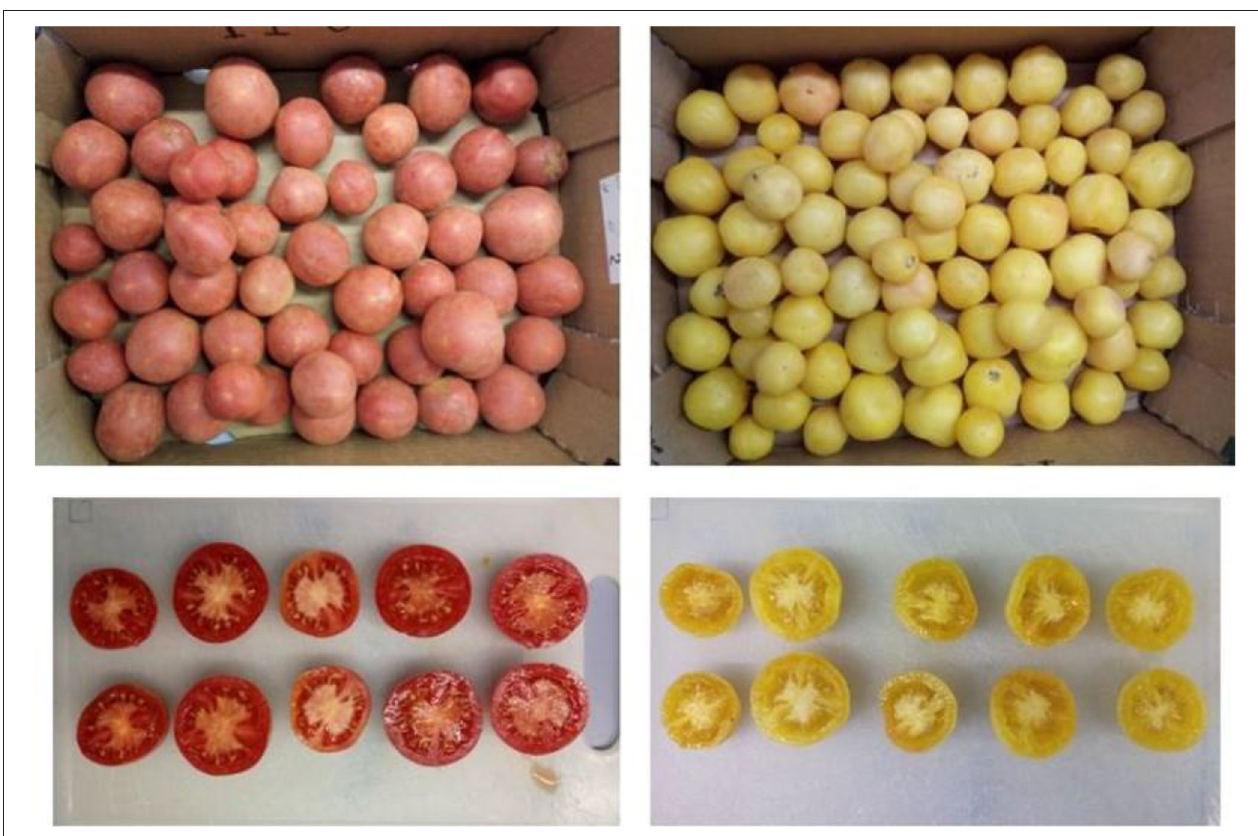
FIGURE 1 | Red and yellow type of tomatoes cv.